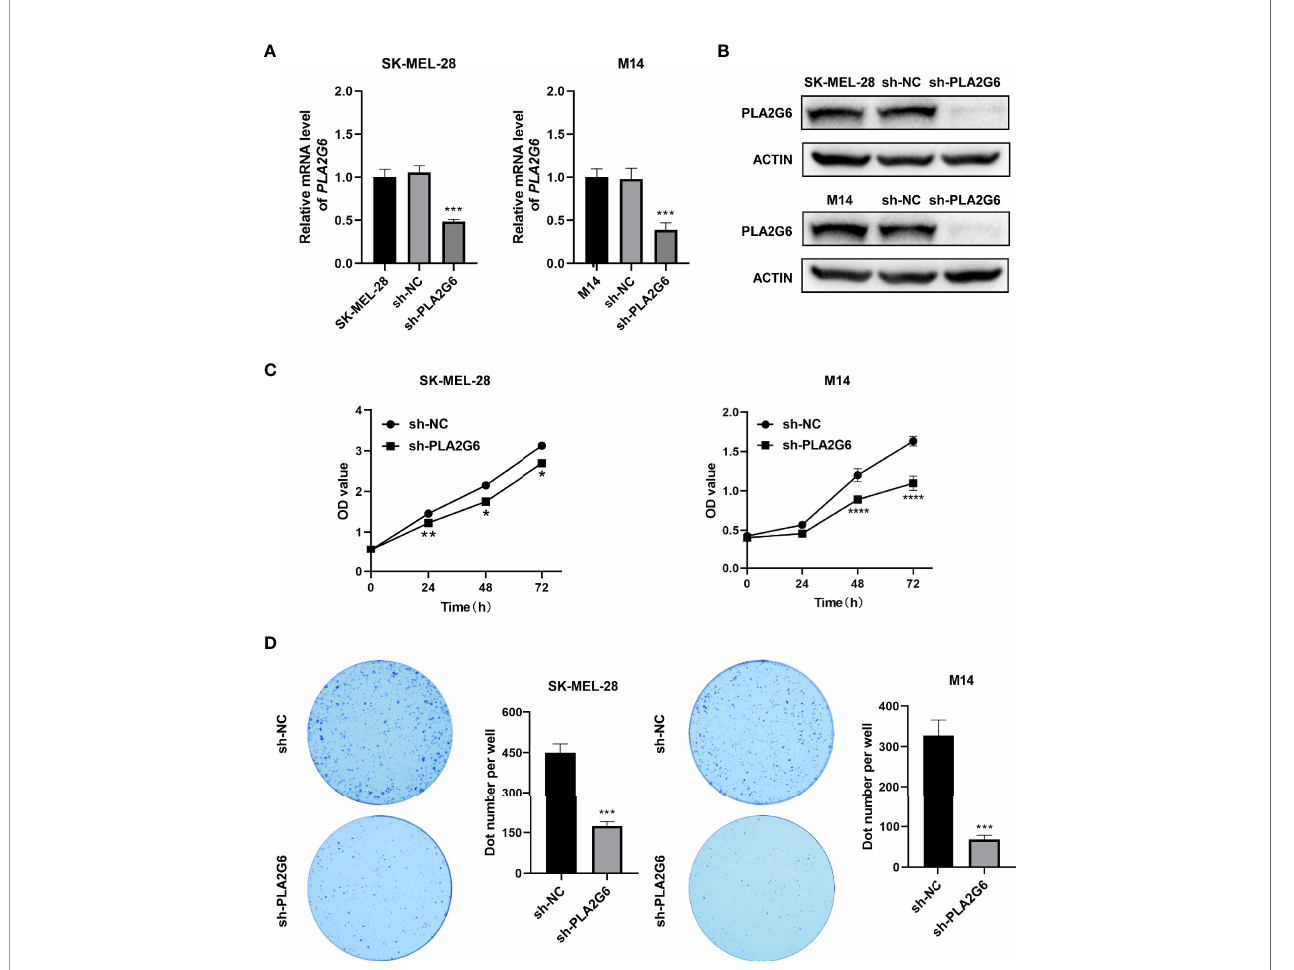
FIGURE 3 | PLA2G6 knockdown suppresses the proliferative ability of SK-MEL-28 and M14 melanoma cells in vitro . (A) RT-qPCR and (B) Western blotting analysis was performed to detect the knockdown ef fi ciency of sh-PLA2G6 and sh-NC. (C) Cell viability was measured by CCK-8 assay in SK-MEL-28 and M14 cells. (D) Images of colony formation and the quanti fi cation of the number of colonies are exhibited. * P < 0.05, ** P < 0.01, *** P < 0.001, **** P <